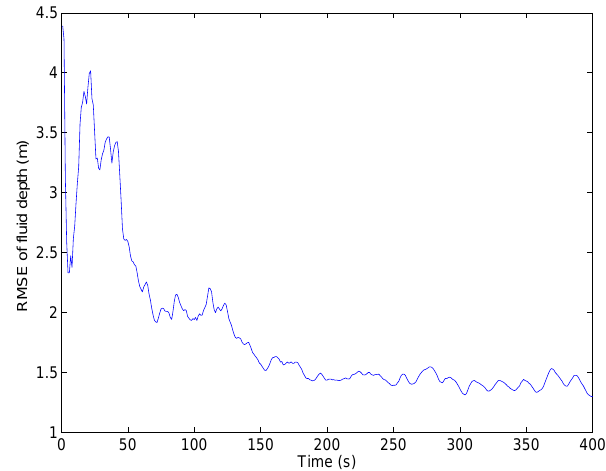
Figure 4. RMSE of fluid depth for the coarse grid simulation as compared to the regular grid mesh using the baseline turbulence